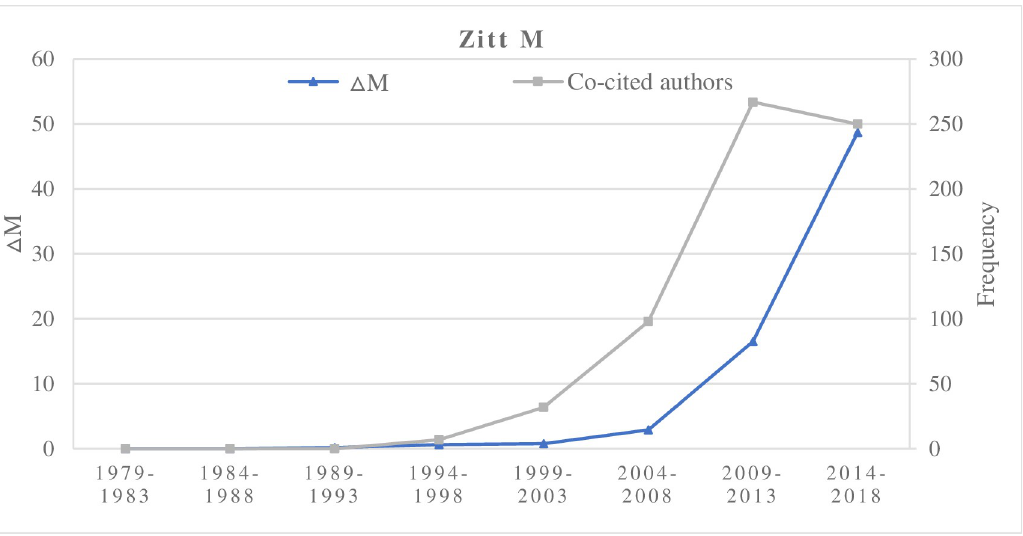
Fig 3. The increase of Δ M and co-cited authors of Zitt